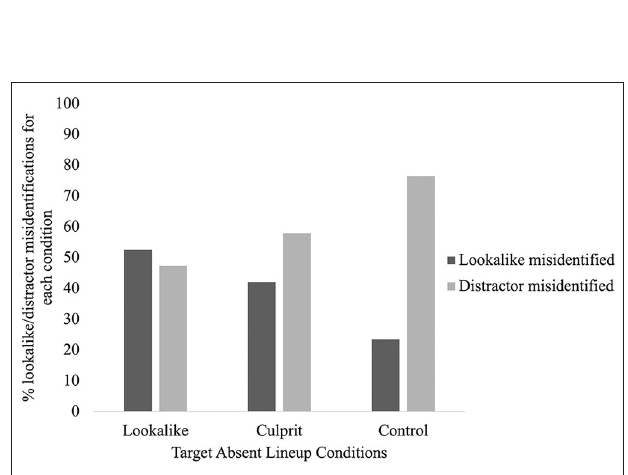
see social media at all. However, it is interesting to see from Figure 2 that the proportion of correct and incorrect responses in the culprit and control conditions are almost identical (62 and 61.36% were correct, respectively), while the pattern in the lookalike condition is slightly different (54.76% were